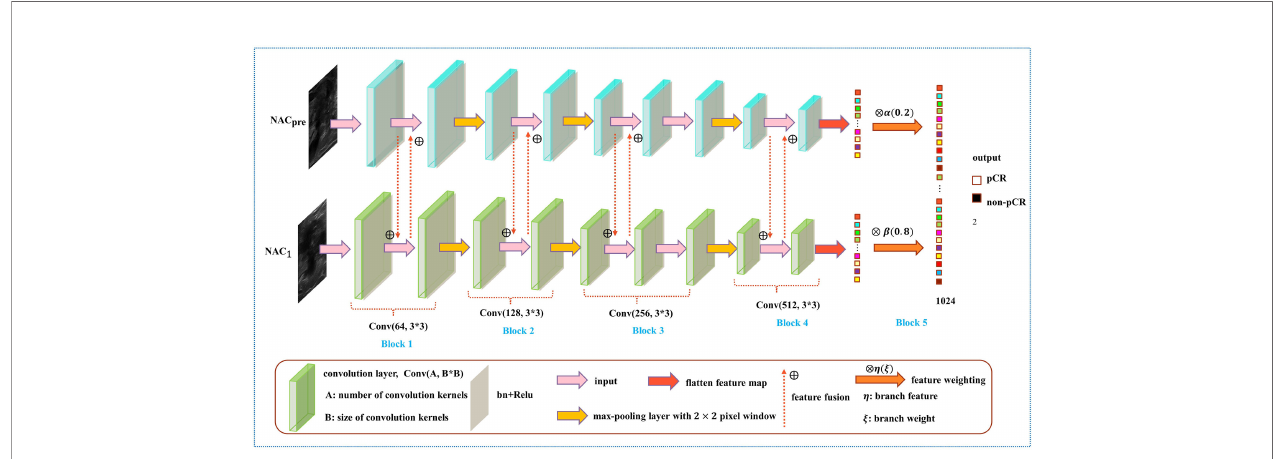
FIGURE 4 | Overview of the DBNN model